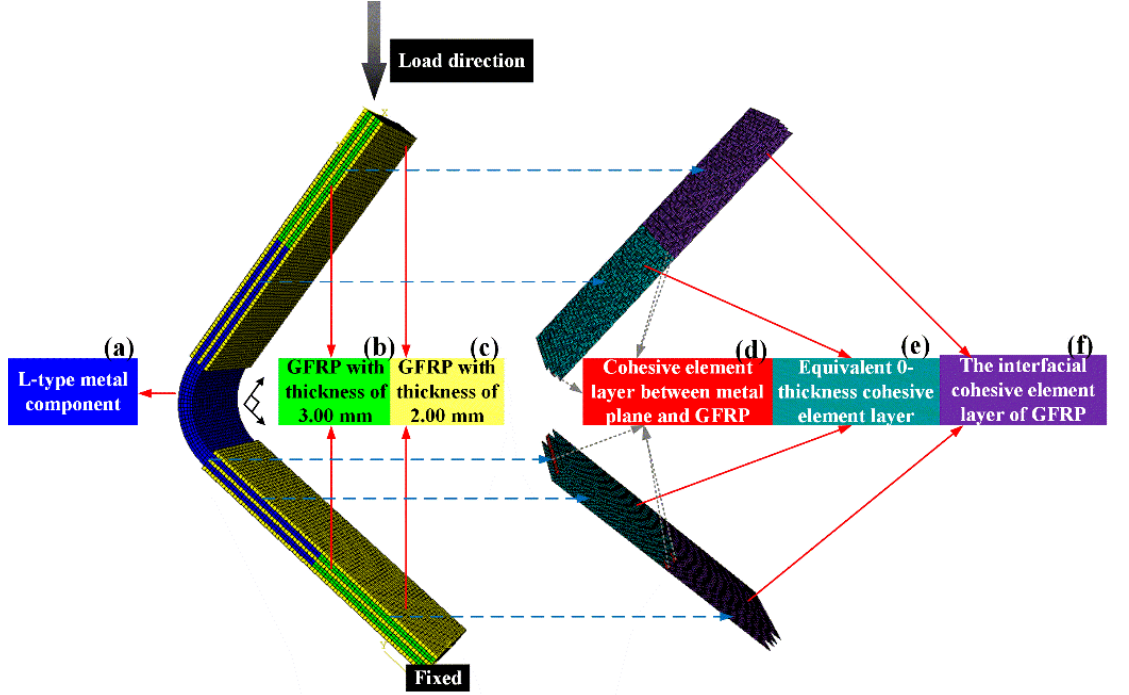
Figure 9. Metal-composite L-joint model mesh and loading conditions: ( a ) L-type metal component; ( b ) GFRP with thickness of 3.00 mm; ( c ) GFRP with thickness of 2.00 mm; ( d ) Cohesive element layer between metal plane and GFRP; ( e ) Equivalent 0-thickness cohesive element layer; ( f ) The interfacial cohesive element layer of GFRP.